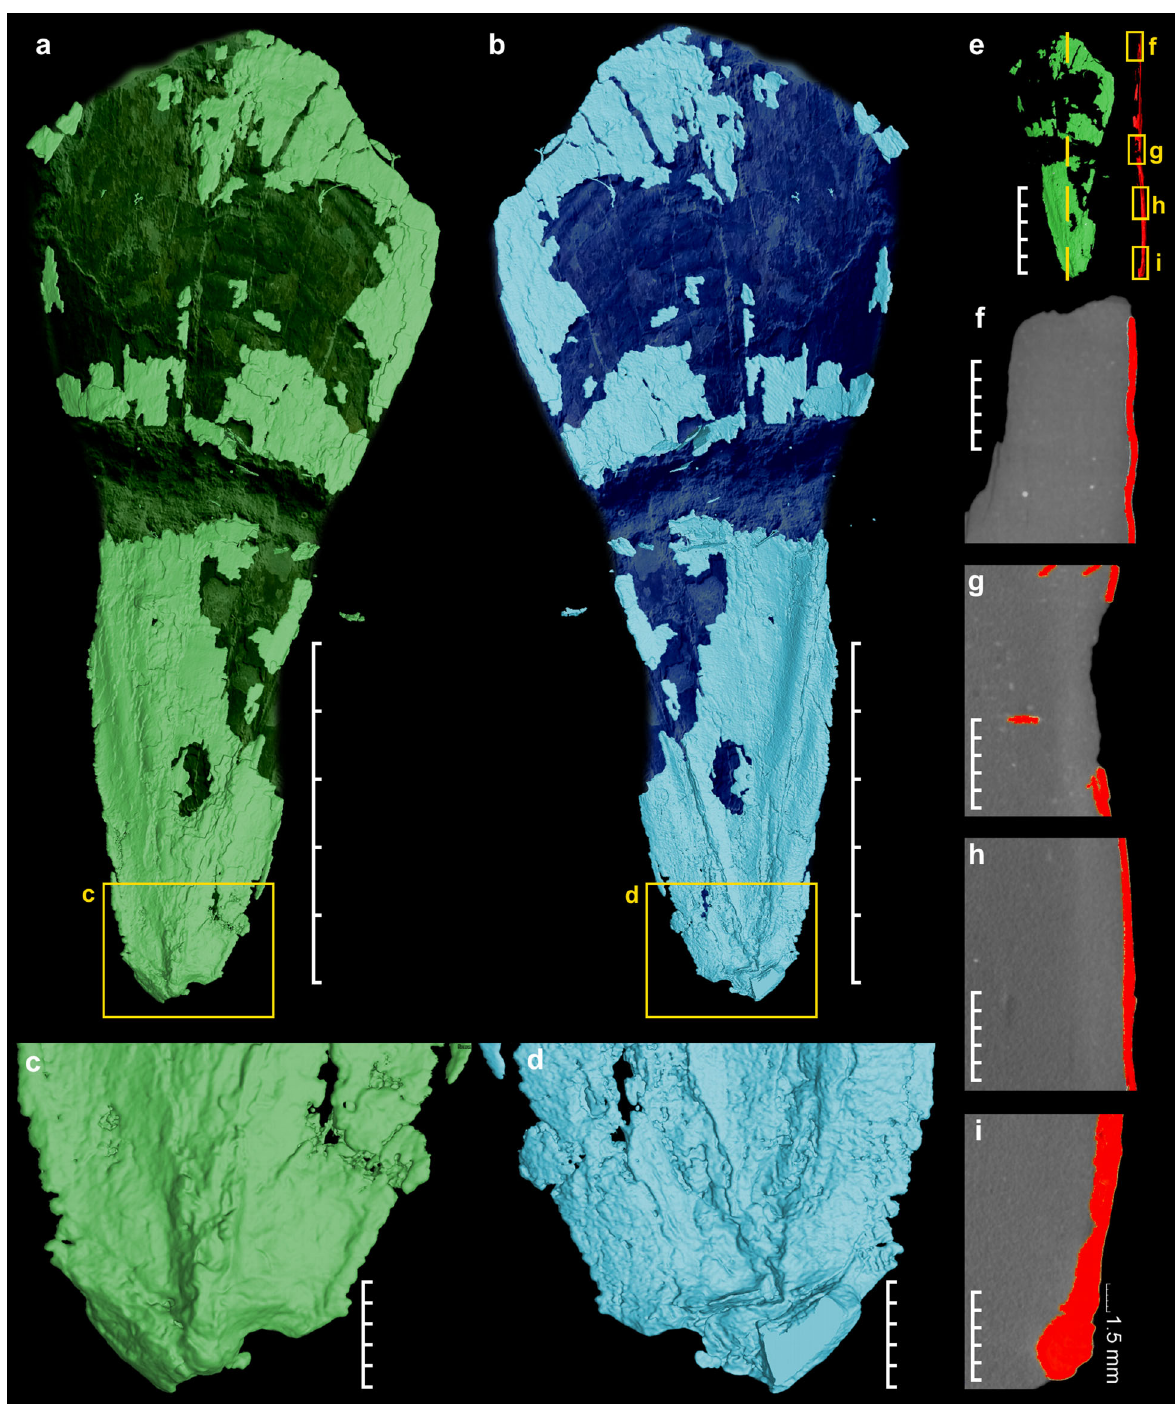
Fig. 2 Micro-CT visualization of the gladius N. hungarica . a Dorsal view. b Ventral view showing typical traingular median fi eld (scale bars a , b = 5 cm). c detail of the posterior part forming conus, dorsal view. d detail of the posterior part lateral fi elds expansion, ventral view (scale bars c , d = 1 cm). e Position of lateral micro-CT sections ( f – i ), scale bar = 5 cm. f – i Lateral gladius sections (red color) documenting rise of thickness towards the apex (conical part), scale bars = 0.5